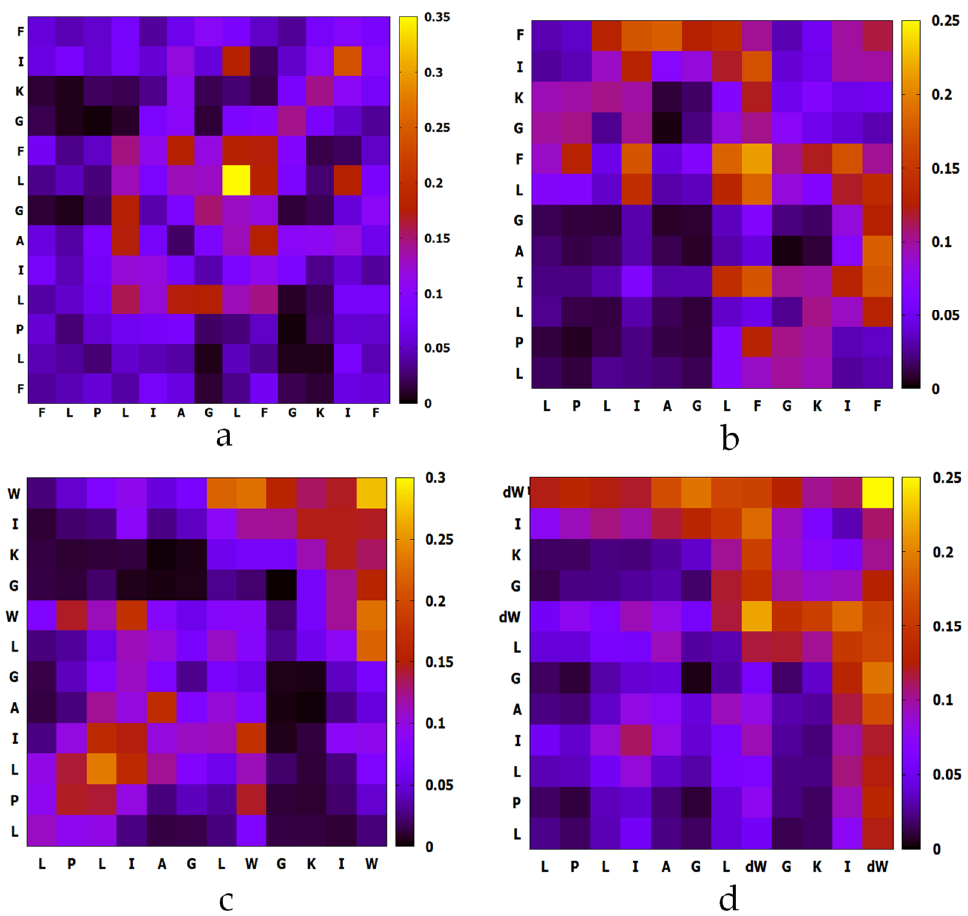
Figure 7. The contact heat maps of the amino acid residues between any of two monomers of ( a ) TPF, ( b ) des-Phe1 TPF, ( c ) W-des-Phe1 TPF, and ( d ) dW-des-Phe1 TPF in the formation of an oligomer during the 100 ns simulation aggregation of six peptide monomers. The color scale indicates the probabilities of contact between any of the two peptide monomers.